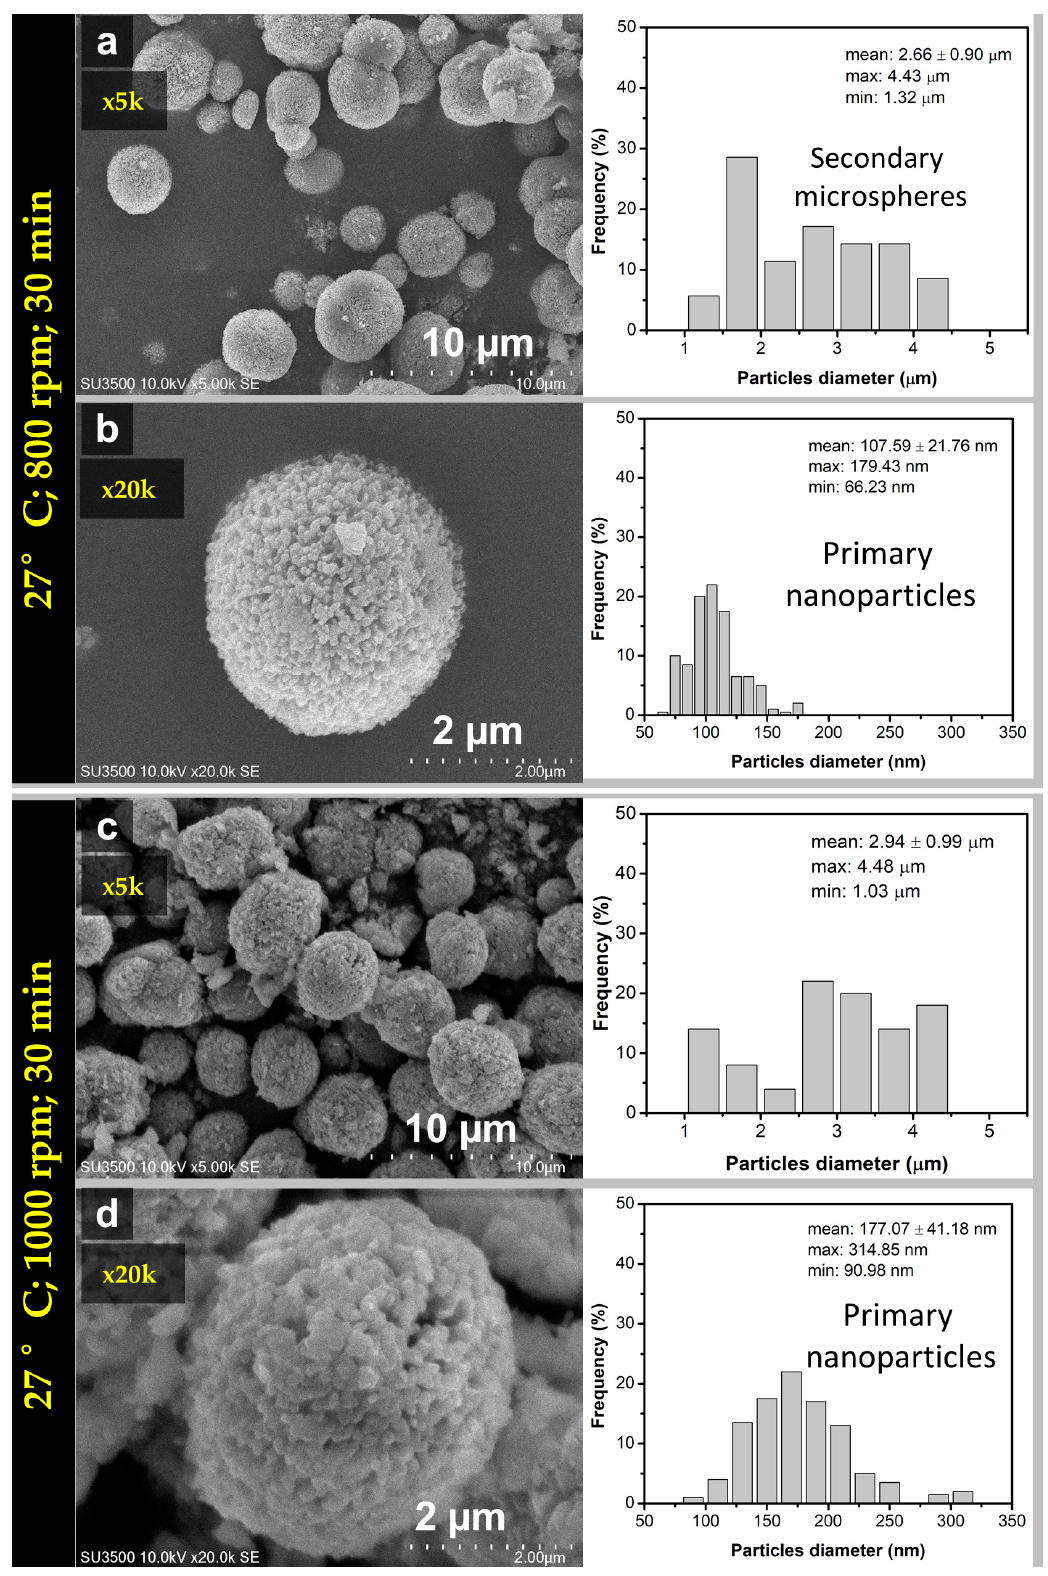
Figure 7. SEM images and particles size distribution of vaterite synthesized at 27 ◦ C (time reaction 30 min) for different stirring speeds ( a , b ) 800 rpm and ( c , d ) 1000